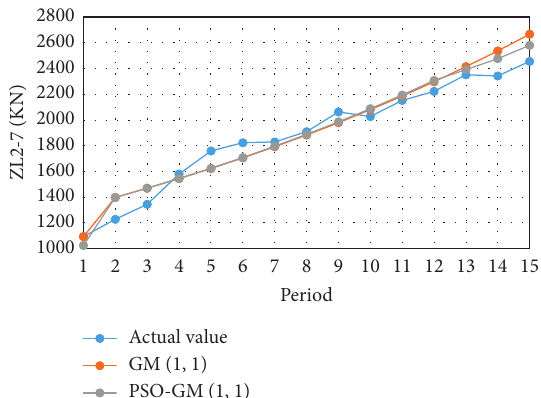
Figure 6: Comparison of actual and predicted values.